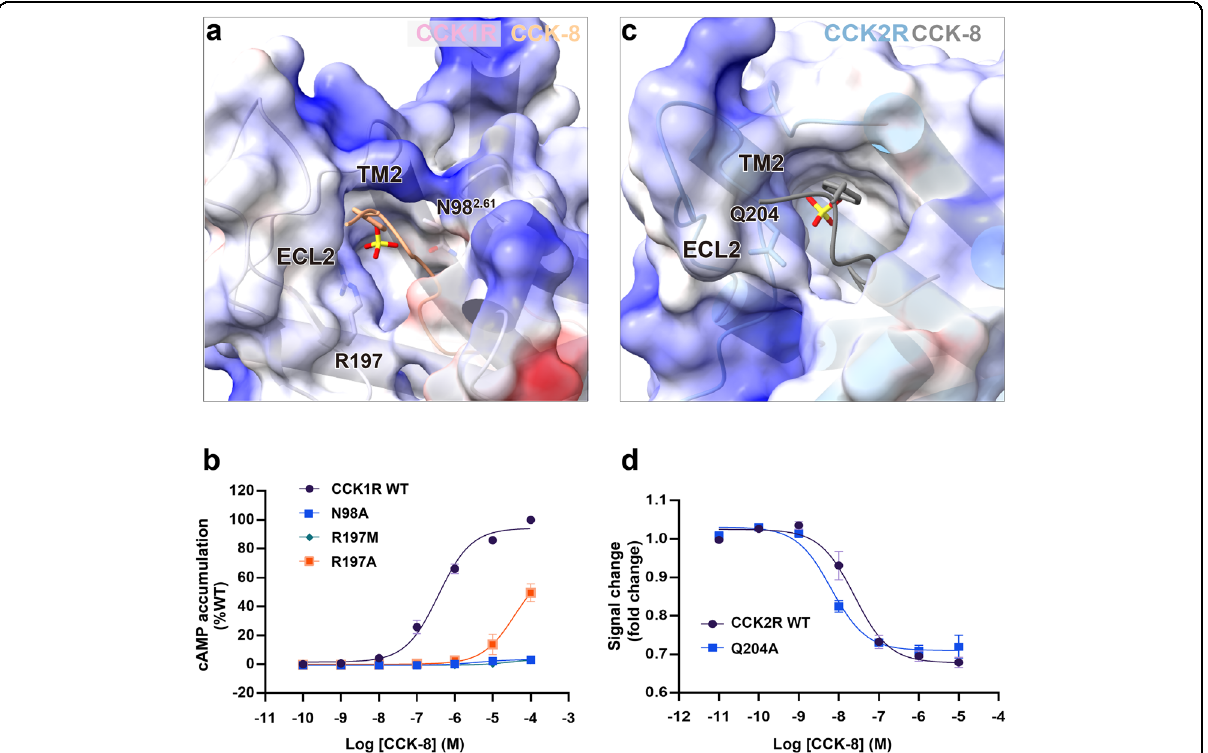
Fig. 3 Ligand selectivity of CCK1R for sulfated CCK. a Electrostatic potential map of the binding pocket in CCK1R for the sulfated tyrosine of CCK- 8. b The effect of N98A, R197A, or R197M mutation in CCK1R on CCK-8-induced cAMP accumulation. c Electrostatic potential map of the binding pocket in CCK2R for the sulfated tyrosine of CCK-8. d The effect of Q204A mutation in CCK2R on CCK-8-induced G α q – G γ